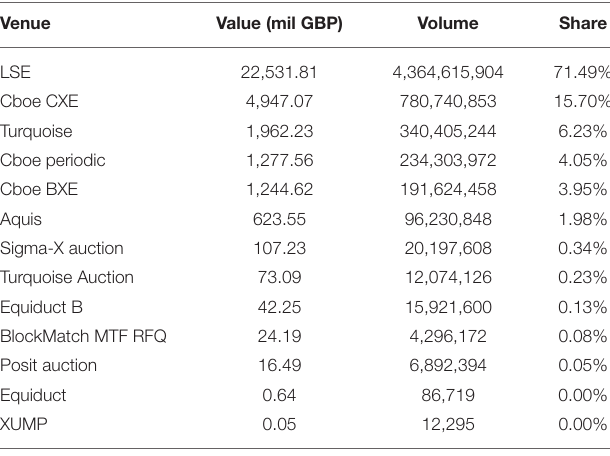
TABLE 1 | FTSE 100 market share by venue—week ending 04 July 2018.